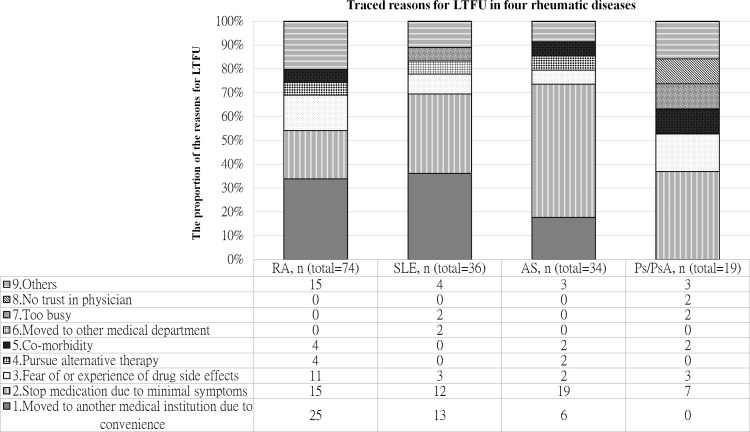
Traced reasons for LTFU.The figure illustrates the proportion of the reasons for LTFU in the four rheumatic diseases.